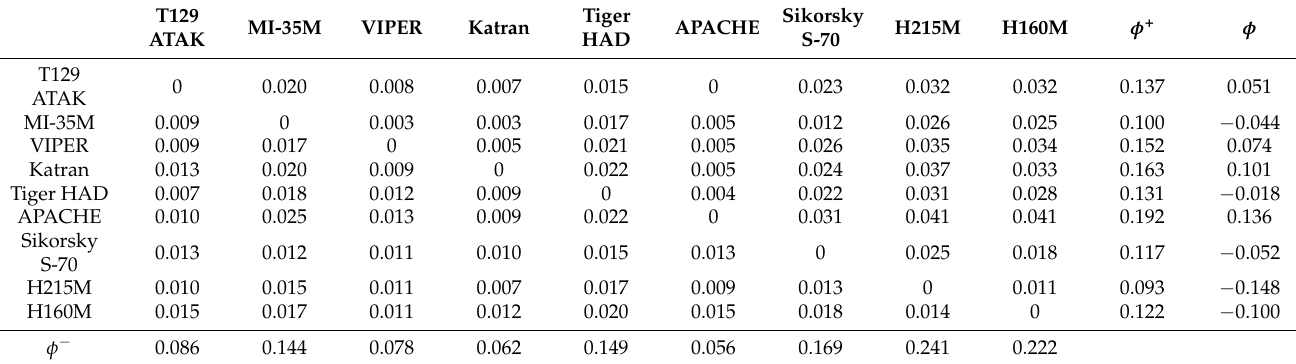
Table 13. Global Index of preference along with the outranking